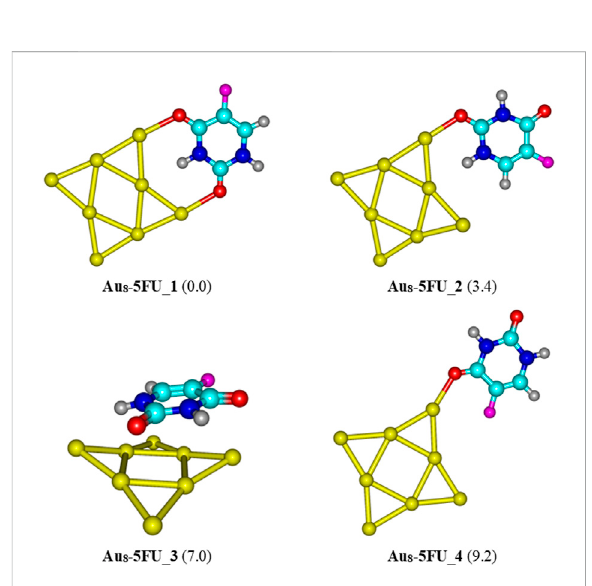
FIGURE 5 Low-lying structures of the Au 8 -5FU complex in gas phase. Valuesindicatedinparenthesesaretherelativeenergies(kcal/mol) with respect to the most stable isomer Au 8 -5FU_1. Yellow, cyan, blue, white-gray, red, and magenta are used to represent the Au, C, N, H, O, and F atoms, respectively.